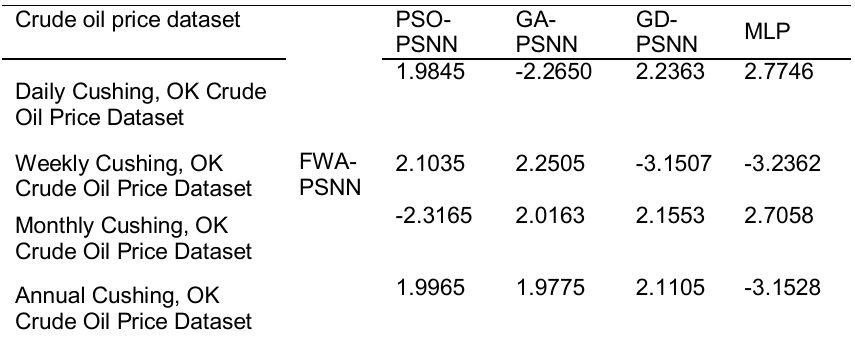
Table 4 . Computed DM statistic